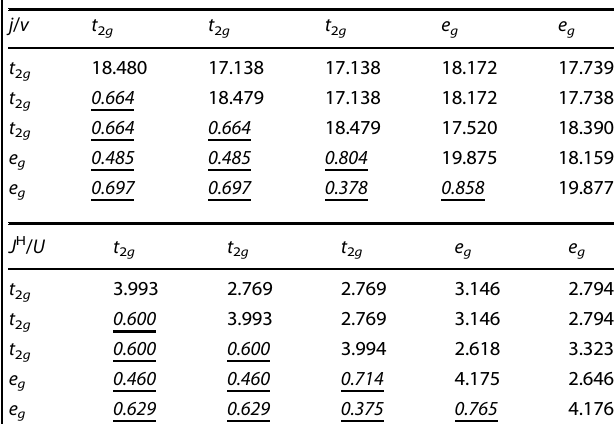
Table 3. Bare ( v / j H ) and cRPA screened ( U / J H ) local Coulomb interaction matrix elements from the ( d + p ) basis set in